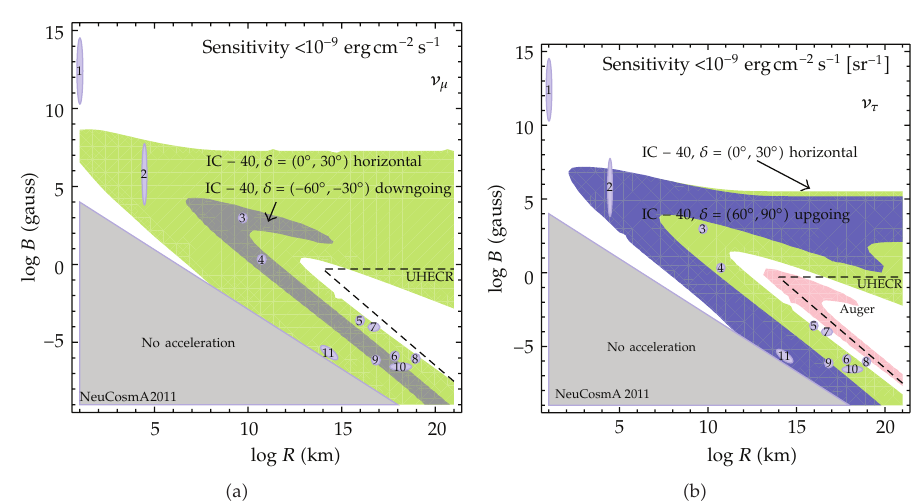
Figure 11: Regions where the sensitivity in F β exceeds 10 − 9 ergcm − 2 s − 1 (cid:5) sr − 1 (cid:6) for β (cid:10) μ (cid:3) a (cid:4) and β (cid:10) τ (cid:3) b (cid:4) for several selected data samples (cid:3) 90% CL, α (cid:10) 2 (cid:4) . The dashed regions “UHECR” indicate where 10 20 eV cosmic ray protons are expected to be produced in the model. The di ff erent sources (cid:3) test points (cid:4) correspond to the ones in Figure 10, figure taken from (cid:5) 46 (cid:6)